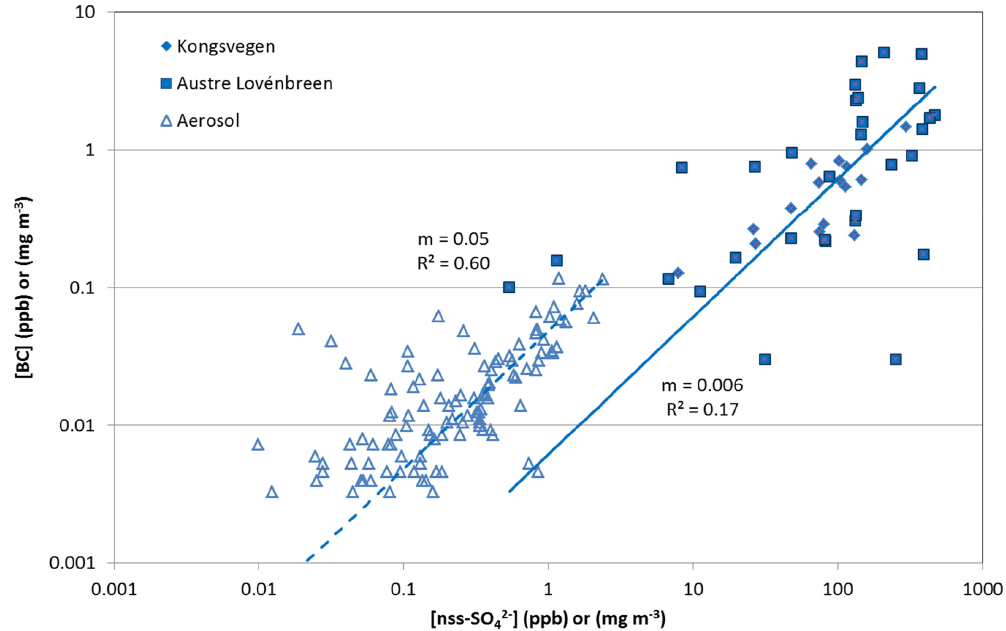
Figure 7. BC vs. nss sulfate concentrations in snow pits KV (filled diamonds) and AL (filled squares) and in aerosols (open triangles). The lines calculated by linear regression with slope m and coefficient of determination R 2 are forced through the origin and separated for the aerosol and snow samples. BC in the snow pits corresponds to rBC, while the BC in aerosols corresponds to eBC.